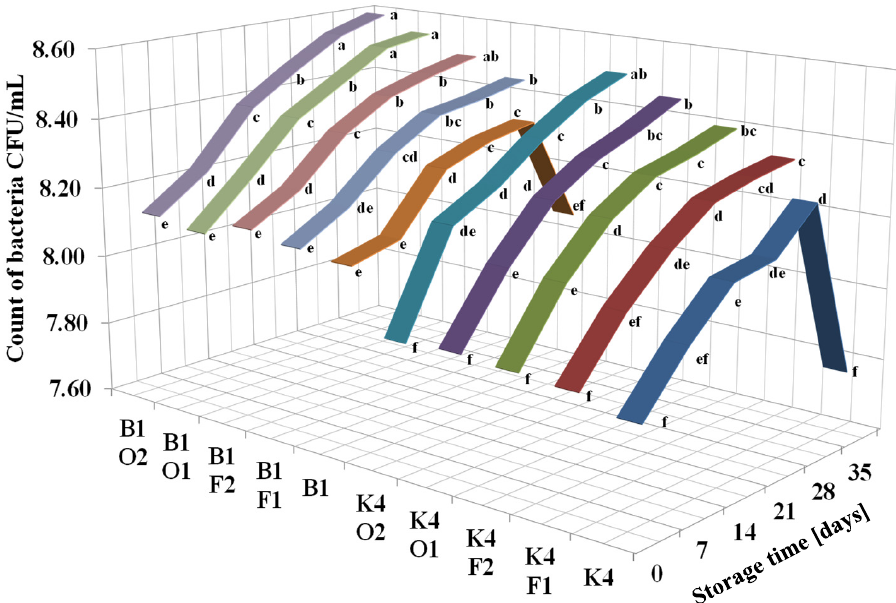
Figure 1. Changes in the Lactobacillus counts in fermented milk samples during storage. The samples were coded according to Materials and methods section, whereby values marked by different letters represent statistically significant differences between variables (storage time and strains) ( p < 0.05) ( n = 3).